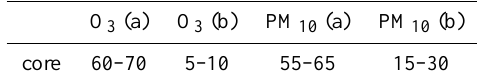
Fig. 6. Daily IM as a function of the frame index for the four se- lected compounds, in the case study 2005-06-17. The Frame index 0 refers to the core region. centration of O3 do not seem to significantly change its be- haviour from frame to frame. Being O3 a secondary and long lived (when not destroyed by titration in presence of high NO levels) specie and, therefore, less connected to local emissions it is more likely to be exported making the be- haviour in the different frames less variable. Looking at the improvements introduced by nudging, no noticeable differ- ences among species can be observed besides PM10 always showing the largest improvement. Improvements can be quantitatively defined using the cen- tred pattern RMS difference (Taylor, 2001) of LR with re- spect to HR (say A ) and the same quantity for LRn ( B ). An Index of Improvement (IM) can be defined as: IM =